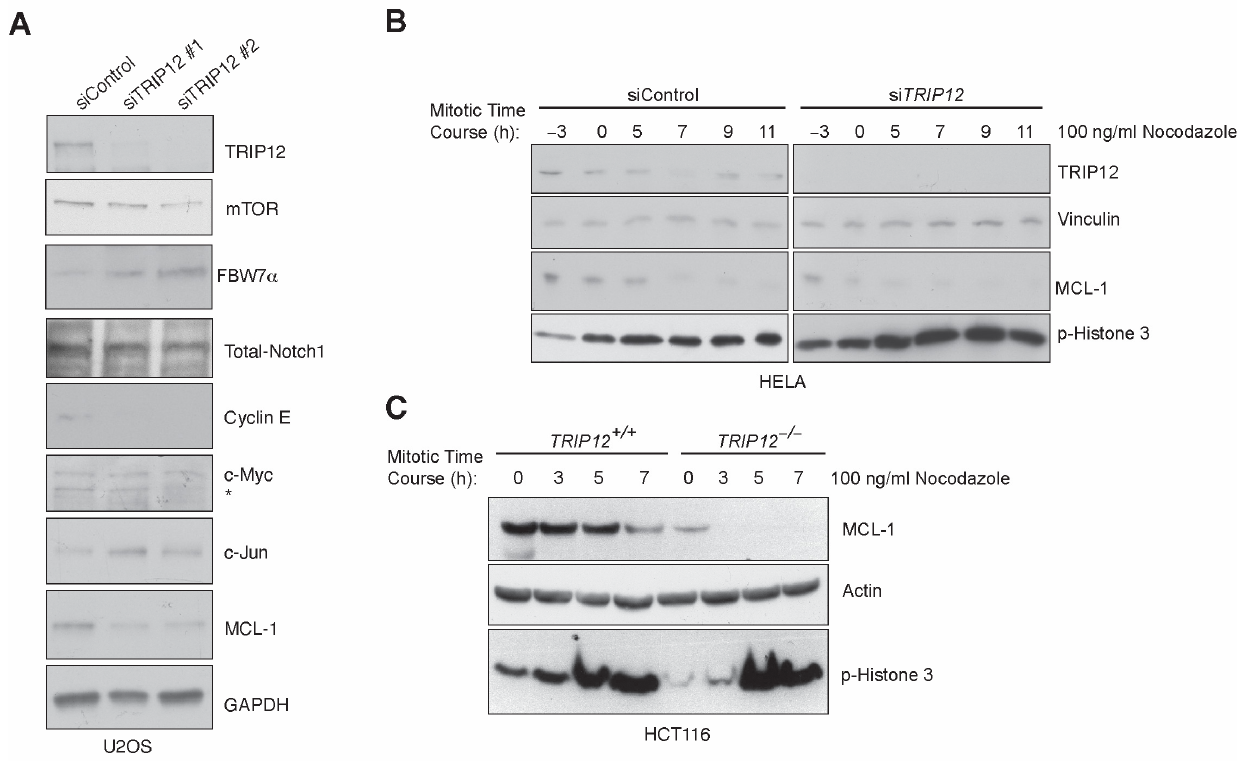
Figure 1. FBW7 protein is stabilized and its substrates mTOR, CyclinE, and MCL ‐ 1 are downregu– lated in TRIP12 depleted cells. ( A ), Western blot validation of FBW7 protein stability and substrates on U2OS cell lysates transfected with two independent siRNAs targeting TRIP12 gene compared to a non ‐ targeting control. Note: *denotes non ‐ specific immunoreactive band. ( B , C ) Immunoblot showing decreased MCL ‐ 1 levels in HELA and HCT116 cells transfected with TRIP12 siRNA fol ‐ lowed by a double thymidine block and subsequent release in 100 ng/mL nocodazole for indicated times relative to ‘0’ h, which is an approximate mitotic onset time after release from thymidine block.